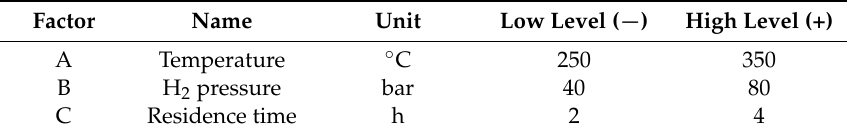
Table 2. Test factors for hydrotreating